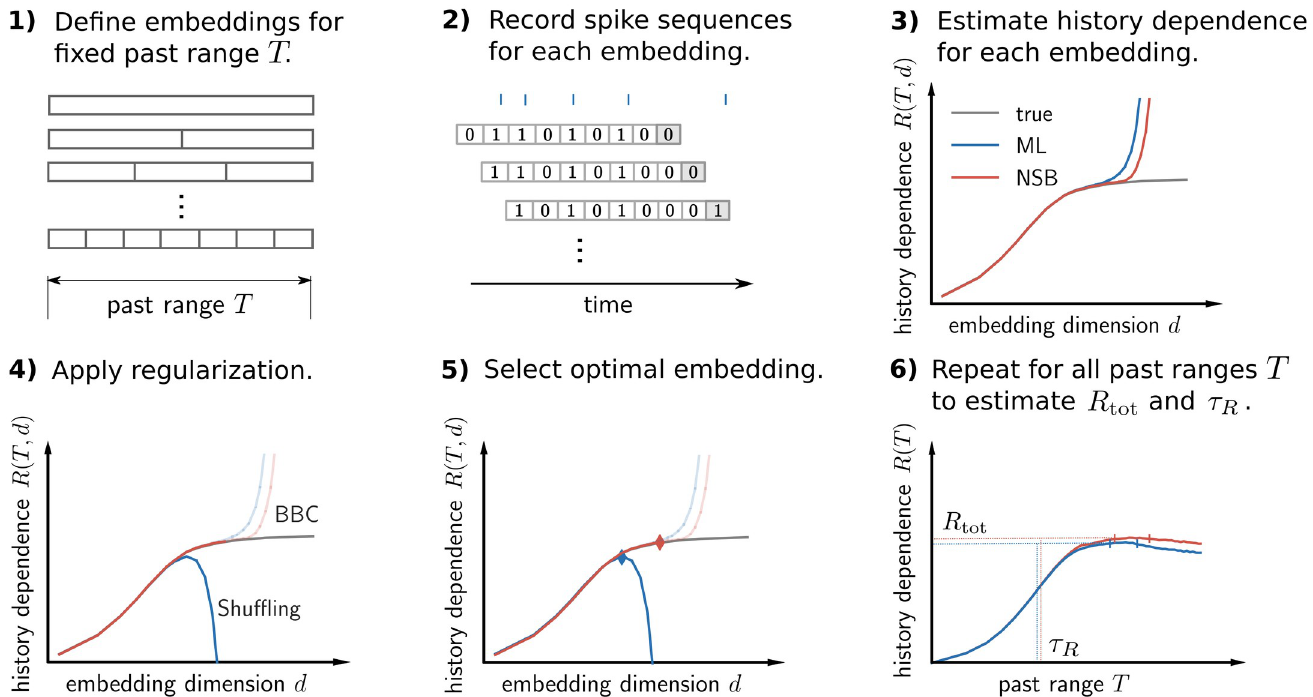
Fig 10. Workflow of past-embedding optimization to estimate history dependence and the information timescale. 1) Define a set of embedding parameters d , κ for fixed past range T . 2) For each embedding d , κ , record sequences of current and past spiking x ; x (cid:0) T for all time steps t n in the recording. 3) Use the frequencies t n t n ; y of the recorded sequences to estimate history dependence for each embedding, either using maximum likelihood (ML), or fully Bayesian estimation (NSB). 4) Apply regularization, i.e. the Bayesian bias criterion (BBC) or Shuffling bias correction, to ensure that all estimates are unbiased or lower bounds to the true history dependence. 5) Select the optimal embedding to obtain an embedding-optimized estimate of R ( T ). 6) Repeat the estimation for a set of past ranges T to compute estimates of the information timescale τ and the total history dependence R tot R